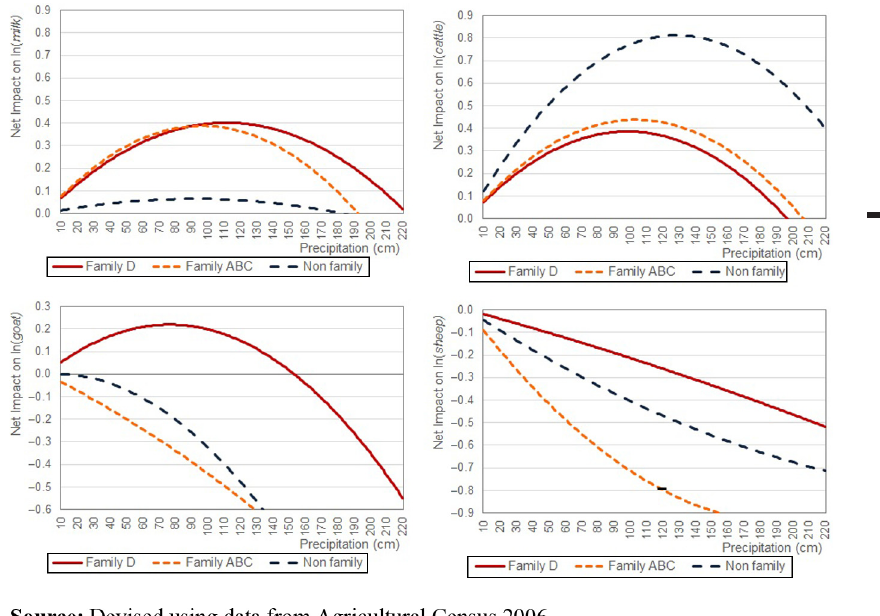
Figure 3. Net impact of precipitation on average log of production,